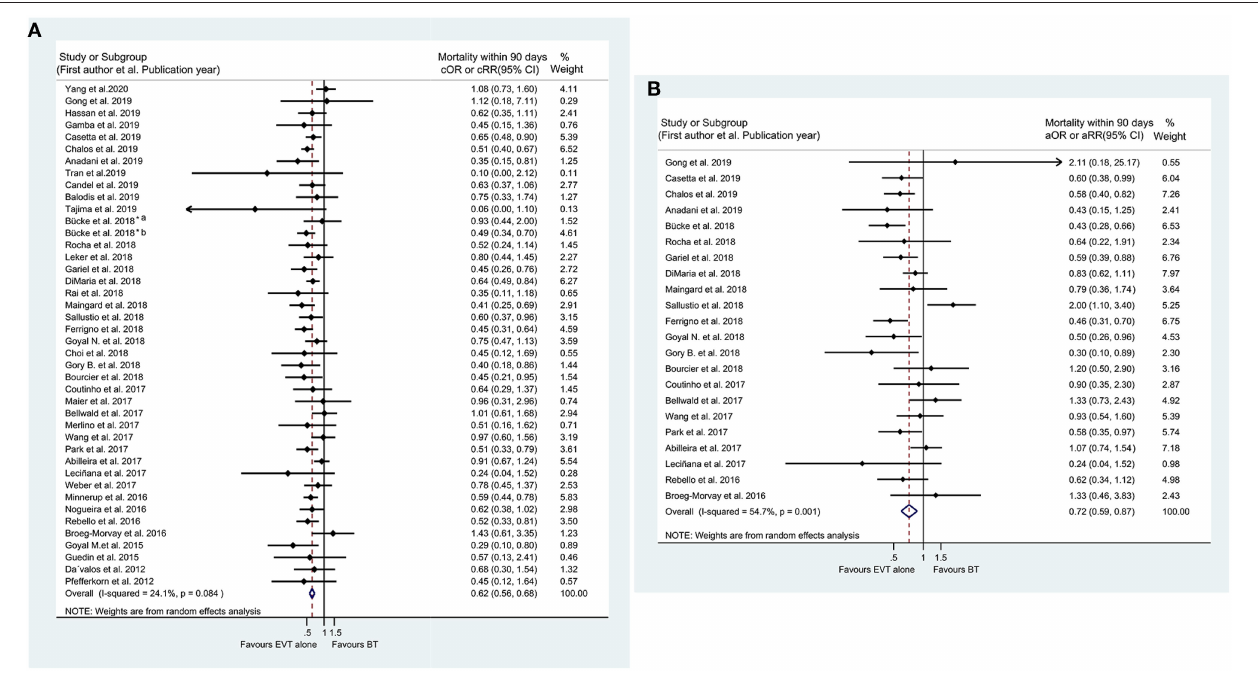
FIGURE 3 | Forest plots of studies assessing mortality within 90 days in unadjusted (A) and adjusted (B) analysis. ICA, internal carotid artery. *The acute intracranial vessel occlusion patients with (a) or without (b) concomitant ipsilateral ICA-occlusion or high-grade stenosis were investigated, respectively, in the study by Bücke et al. (